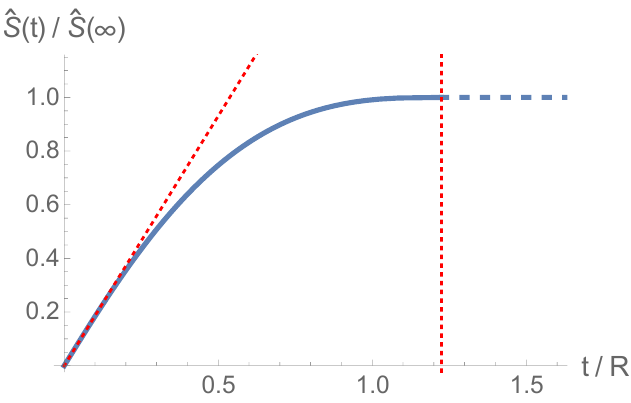
Figure 1. Entropy growth in a global quench for a sphere of radius R in the limit (1.2) in d = 4. The solid blue curve is (1.7), the dashed blue line is the saturation value of the entropy given by a static RT surface, and the dotted red lines indicate (1.4) and (1.8)